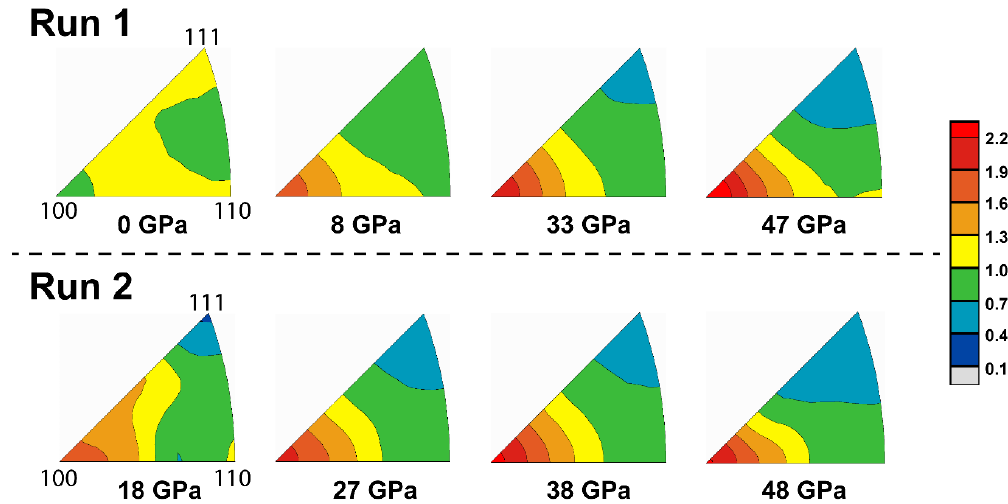
Figure 2. Experimental lattice strains of {200}, {220}, and {111} planes. Rectangles represent data in Run 1; circles represent data in Run 2.